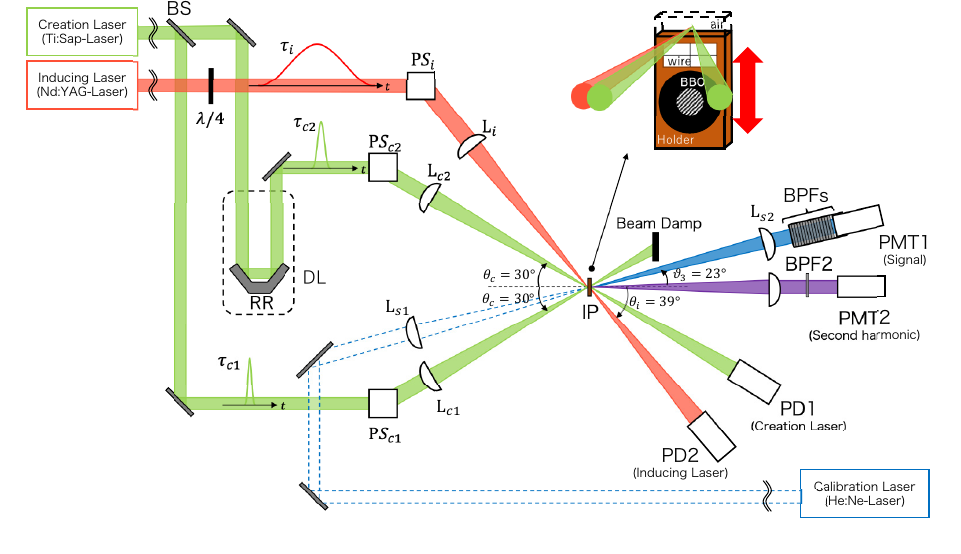
Figure 2. Schematic drawing of the search setup.